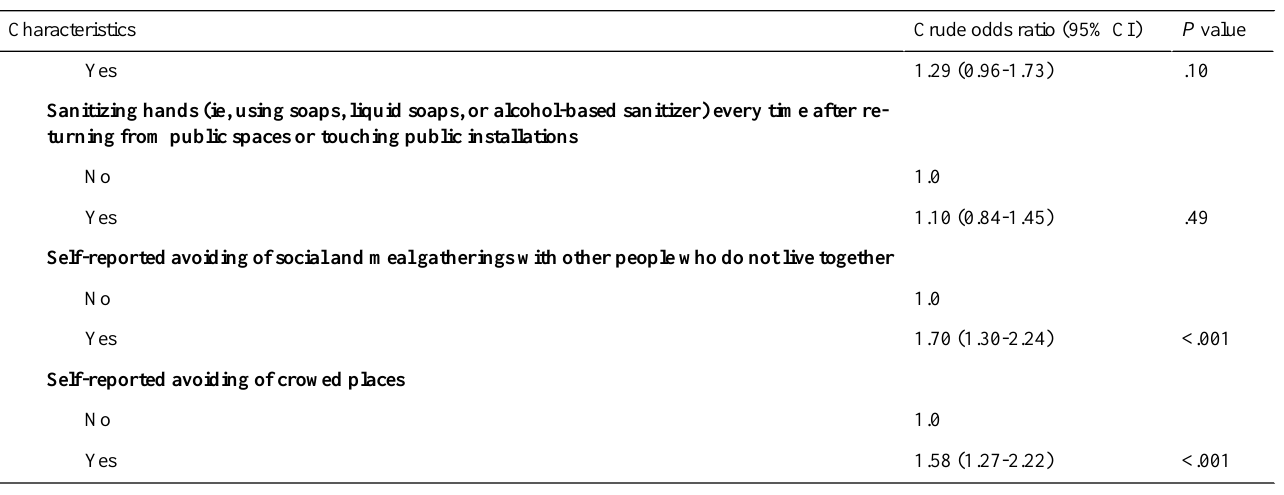
Table 4. Factors associated with parental acceptability of a free COVID-19 vaccination (N=1052). Perceptions related to COVID-19 vaccination based on the theory of planned